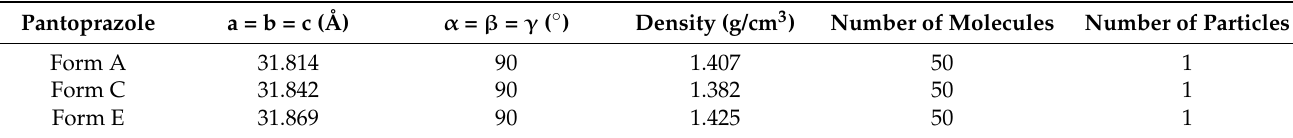
Table 4. Parameters for the corrosion thin-film model